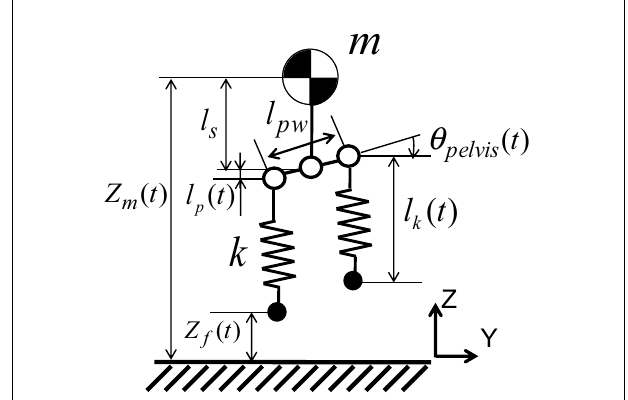
FIGURE 2 | Spring-mass model with pelvis joint (SLIP 2 ) . The model is composed of a body mass, a pelvis, and spring legs.